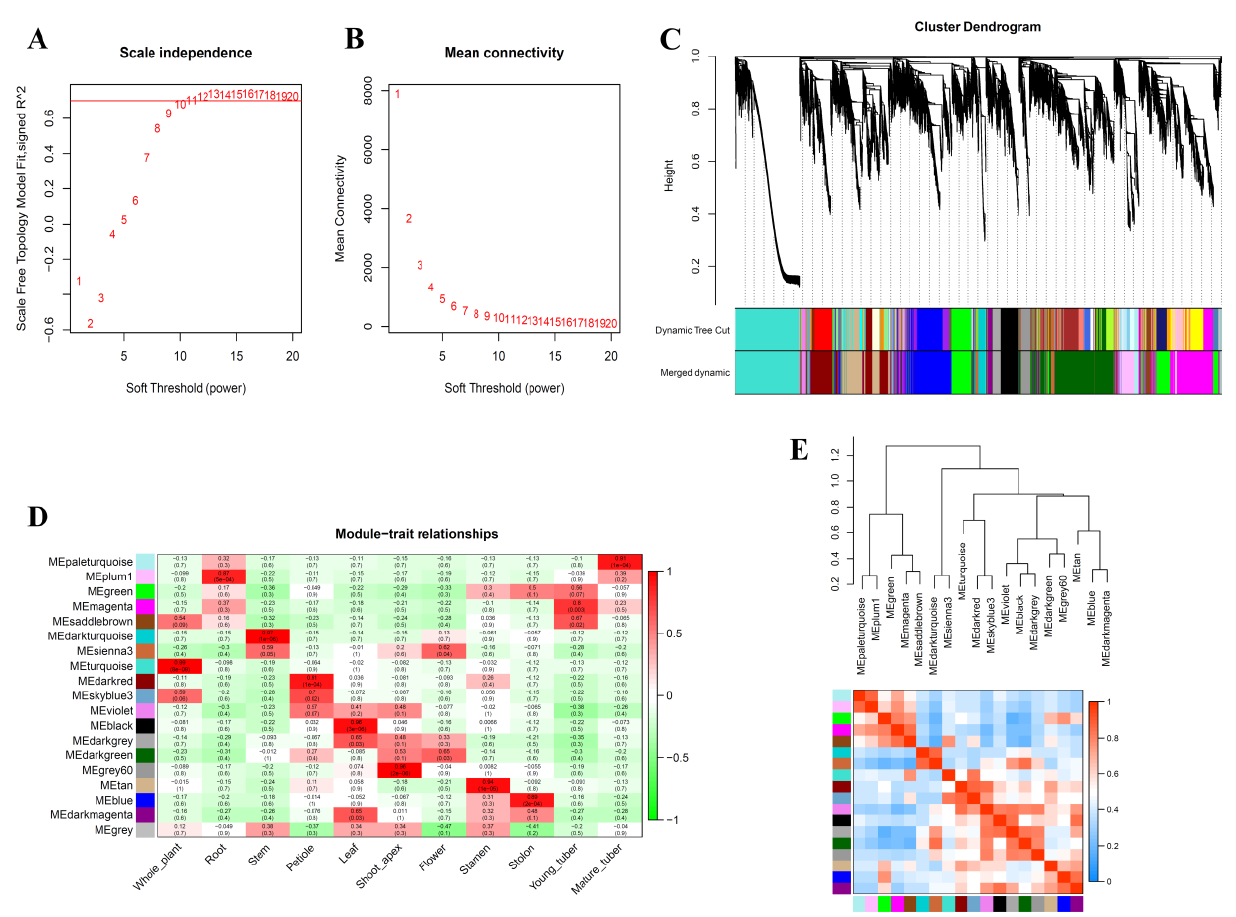
Figure 3. Graphical visualization of the S. tuberosum co − expression network. ( A ) Plot showing the scale free topology R 2 value in function of increasing soft thresholding power. ( B ) Plot showing the relation between mean connectivity and soft threshold. ( C ) Dendrograms produced by average linkage of hierarchical clustering of S. tuberosum genes, which was based on a topological overlap matrix (TOM). The modules were assigned colors as indicated in the horizontal bar beneath the dendrogram. ( D ) Characterizing consensus modules by differential expression of their corresponding eigengenes in the various tissues from potato plant. Red means over − expression, green means underexpression; numbers in each cell give the corresponding t -test p -value. Each column corresponds to a tissue and each row corresponds to an eigengene. ( E ) Clustering dendrograms of consensus module eigengenes for identifying meta − modules (above) and the heatmap for the correlation coefficient between the modules (below). The diagonal plots show heatmap plots of eigengene adjacencies. Each row and column correspond to one eigengene (labeled by consensus module color). Within the heatmap, red indicates high adjacency (positive correlation) and green low adjacency (negative correlation), as shown by the color legend.